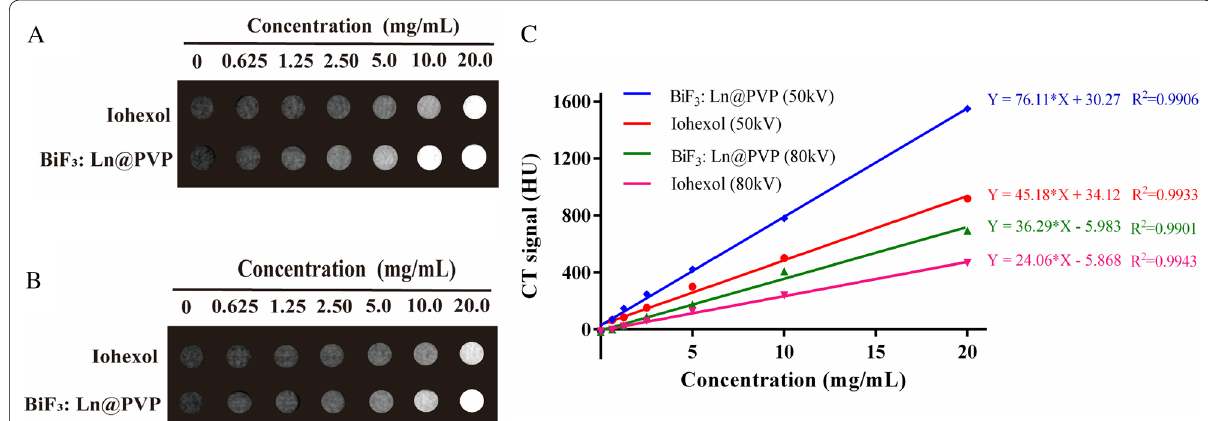
Fig. 6 Comparison of the effect of in vitro CT imaging between BiF 3: Ln@PVP NPs and Iohexol. A , B In vitro CT imaging under different operating voltages (50 and 80 kV, respectively) of BiF 3: Ln@PVP NPs and Iohexol. C The corresponding CT values of BiF 3: Ln@PVP NPs and Iohexol under 50 and 80 kV,